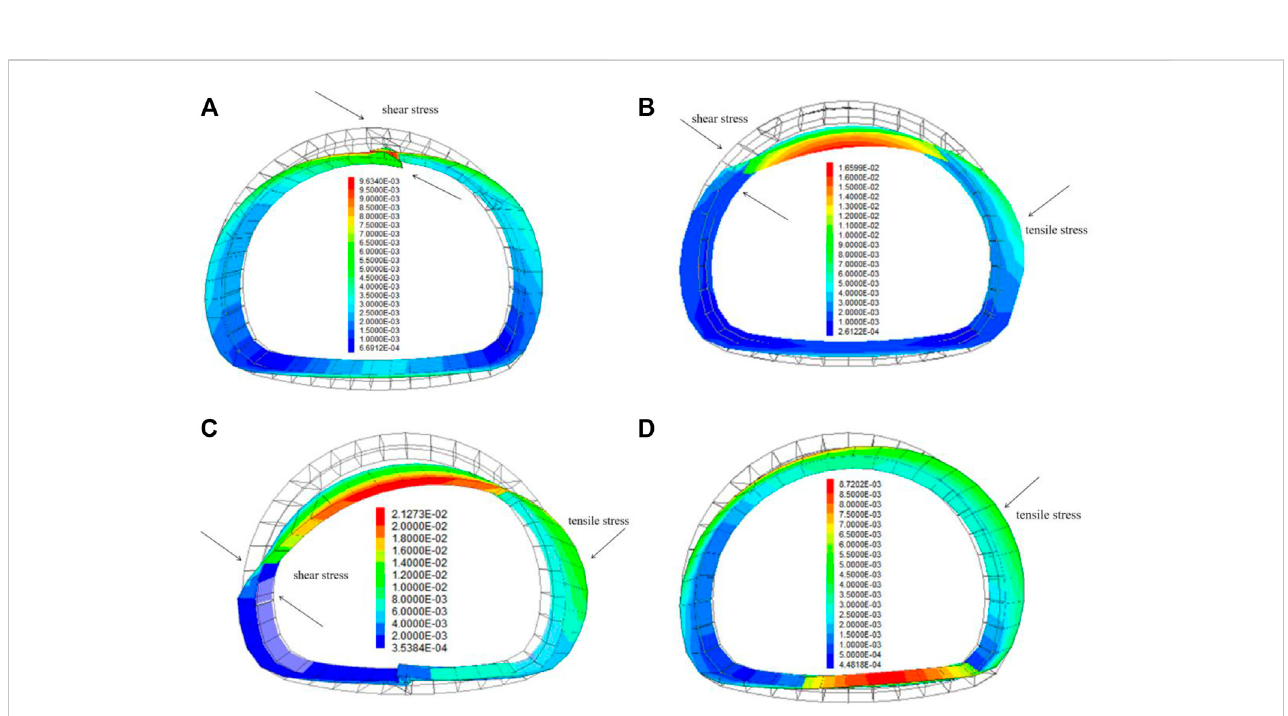
FIGURE 20 Structural displacement of secondary lining under four different conditions (unit: m): (A) Tunnel vault crossing the soil – rock interface; (B) Arch haunch crossing the soil – rock interface; (C) Arch spring crossing the soil – rock interface; and (D) Wall foot crossing the soil – rock interface.